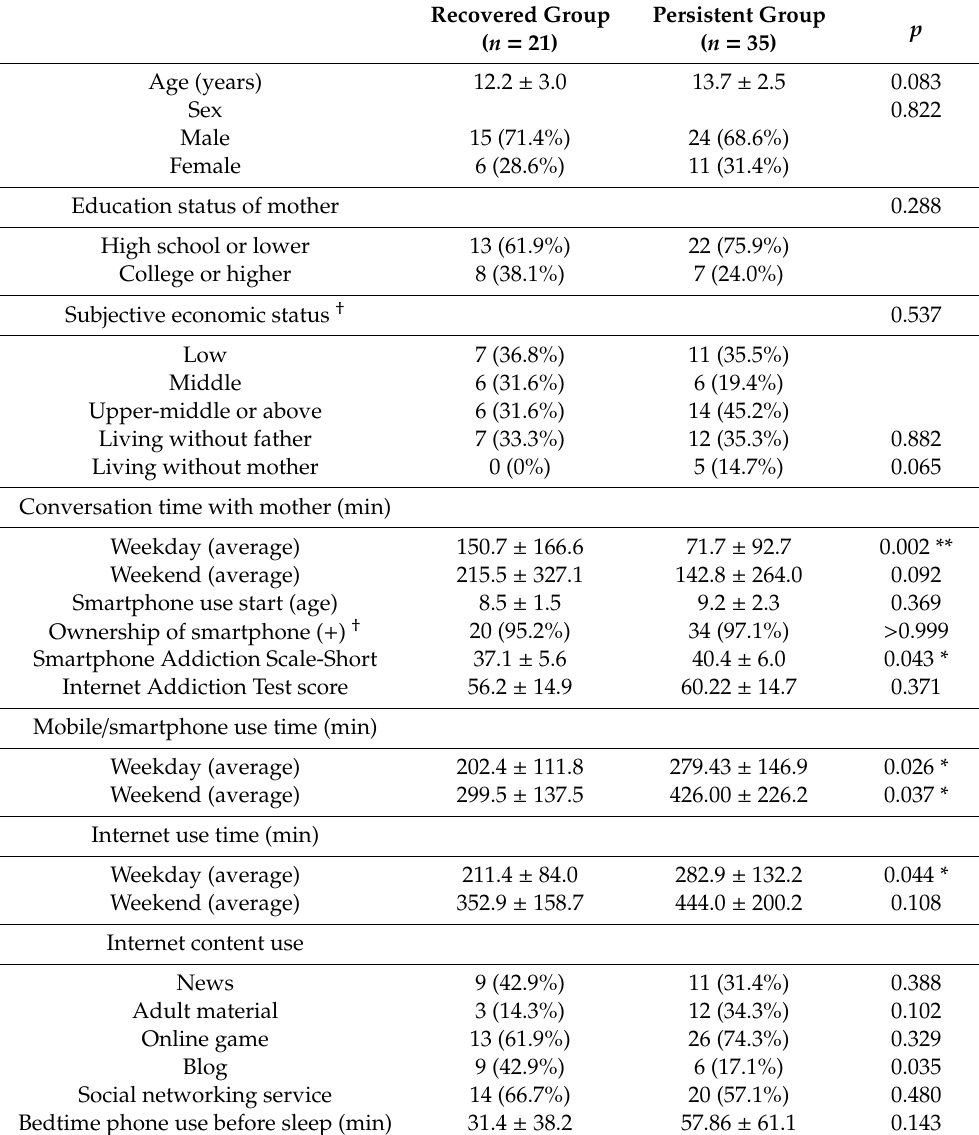
Table 1. Baseline comparison of sociodemographic and smartphone-related measures between recovered and persistent